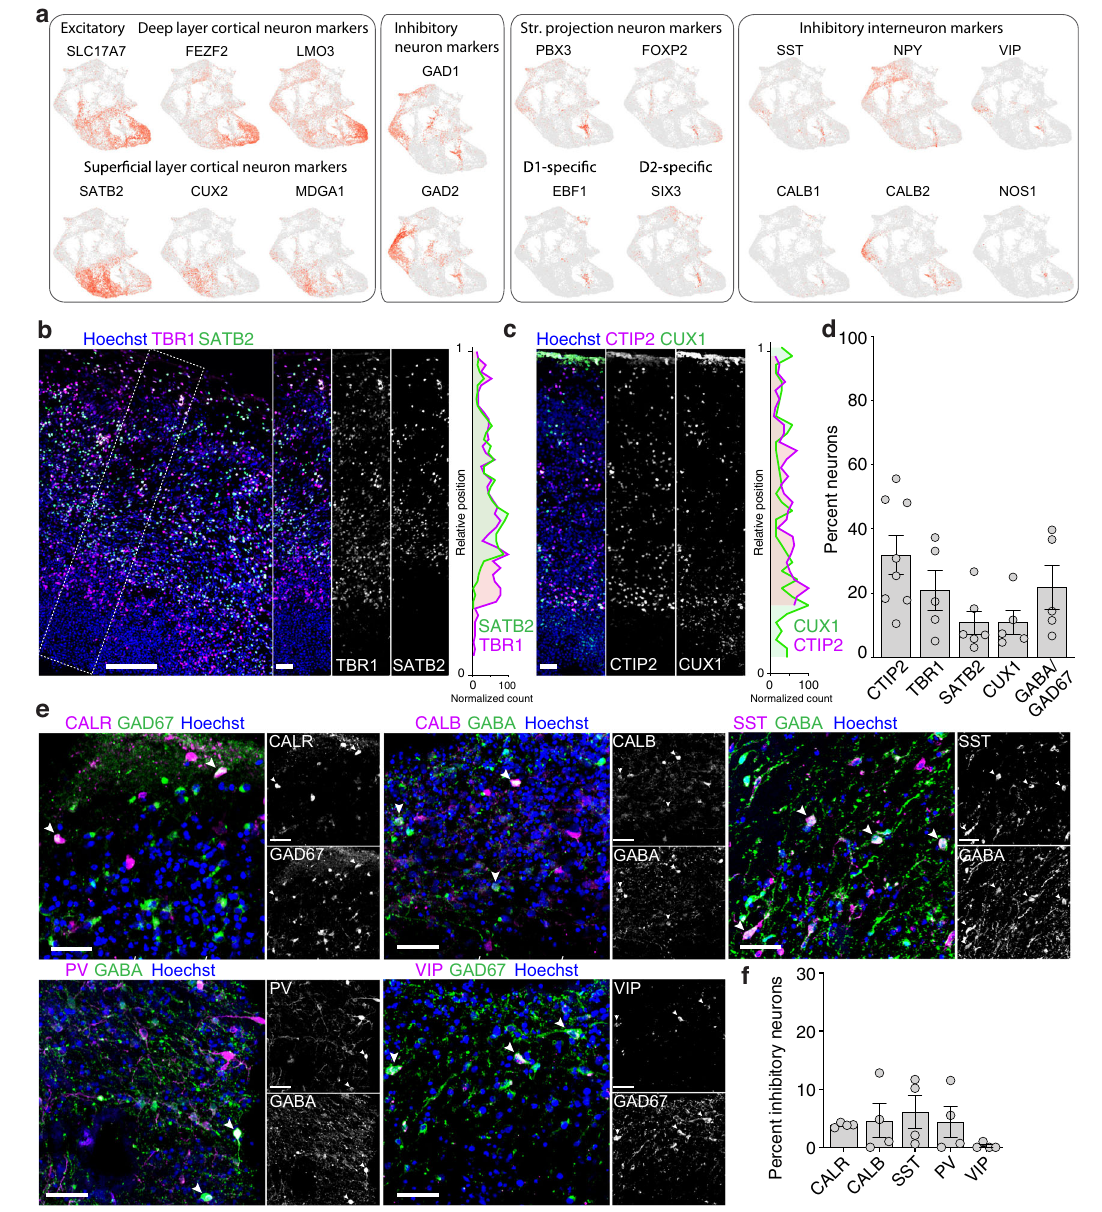
Fig. 7 | Characterization of cortical excitatory neurons and inhibitory inter- neurons in 5-month-old SNR-derived organoids. a Heatmap visualizations of selected neuronal markers. b , c Organoid sections immunostained for TBR1, and SATB2 ( b ) and CTIP2, and CUX1 ( c ) and relative distributions of cells expressing these markers the marked ROIs. d Percentages of cells expressing cell different neuron type-speci fi c markers ( n =8 [CTIP2], 5 [TBR1], 6 [SATB2], 5 [CUX1] and 5 [GABA/GAD67] organoids/1 – 2 sections per organoid produced in 2 – 3 batches from 2242-5 and EP2-15 lines). e Organoid sections immunostained for Calretinin